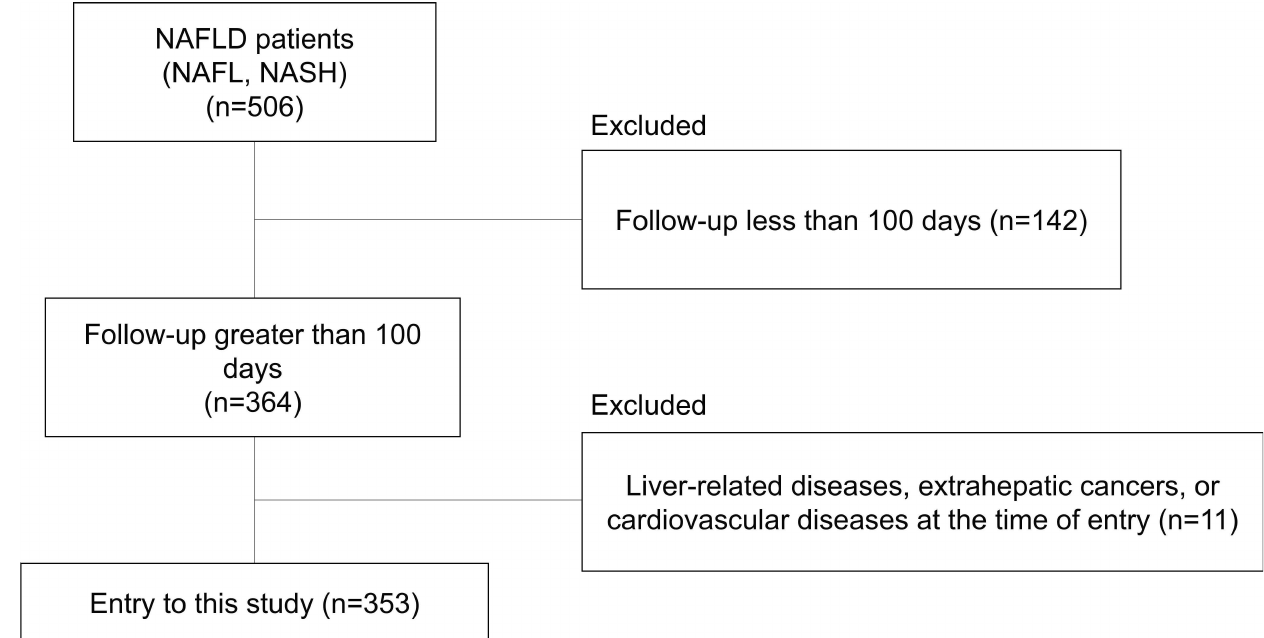
Figure 1. Flow diagram of patient enrollment throughout the